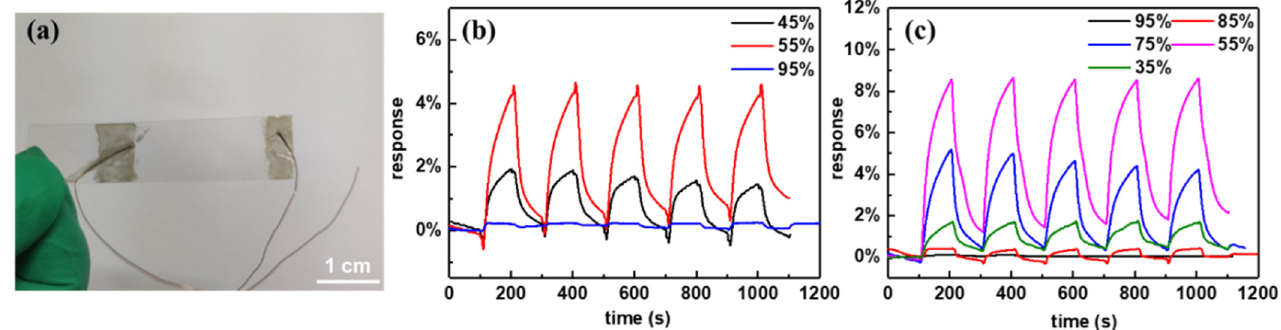
Figure 7. ( a ) Optical images of a hydrogen gas sensor constructed using SWCNT films with a trans- parency of 85%. Responses of ( b ) m-SWCNT and ( c ) s-SWCNT films with different transparencies upon exposure to H 2 with a concentration of 5% (vol.). Reproduced with permission from Ref. [20]. Copyright 2019 Elsevier.